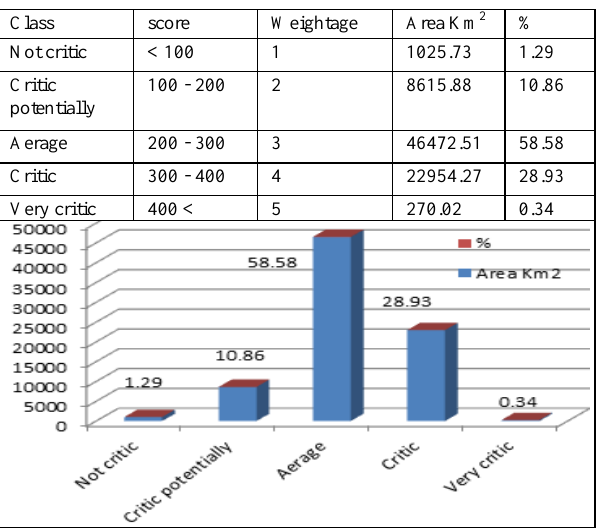
TABLE 9. Classification of land degardation.